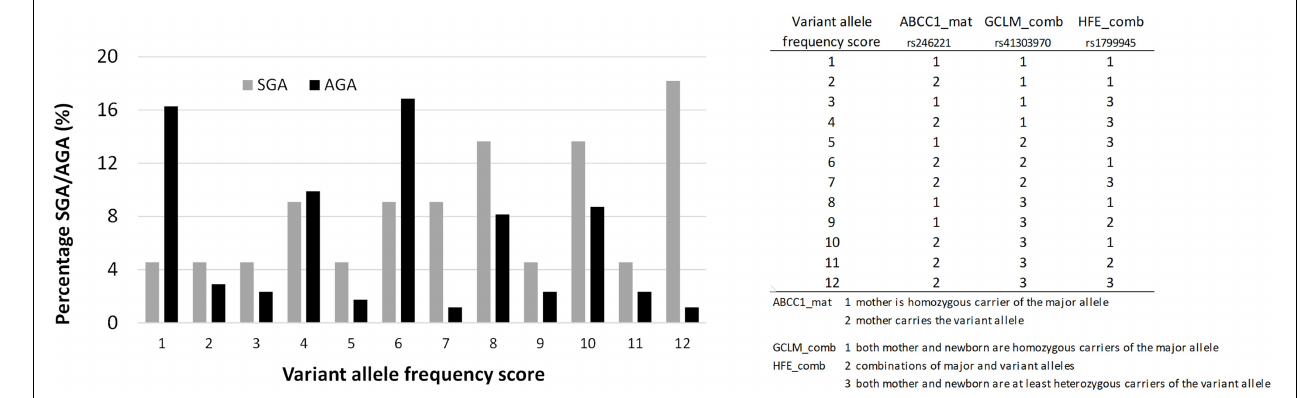
FIGURE 5 | The distribution of ABCC1 , GCLM , and HFE alleles in AGA and SGA cases. Chi-Square test P < 0.05.